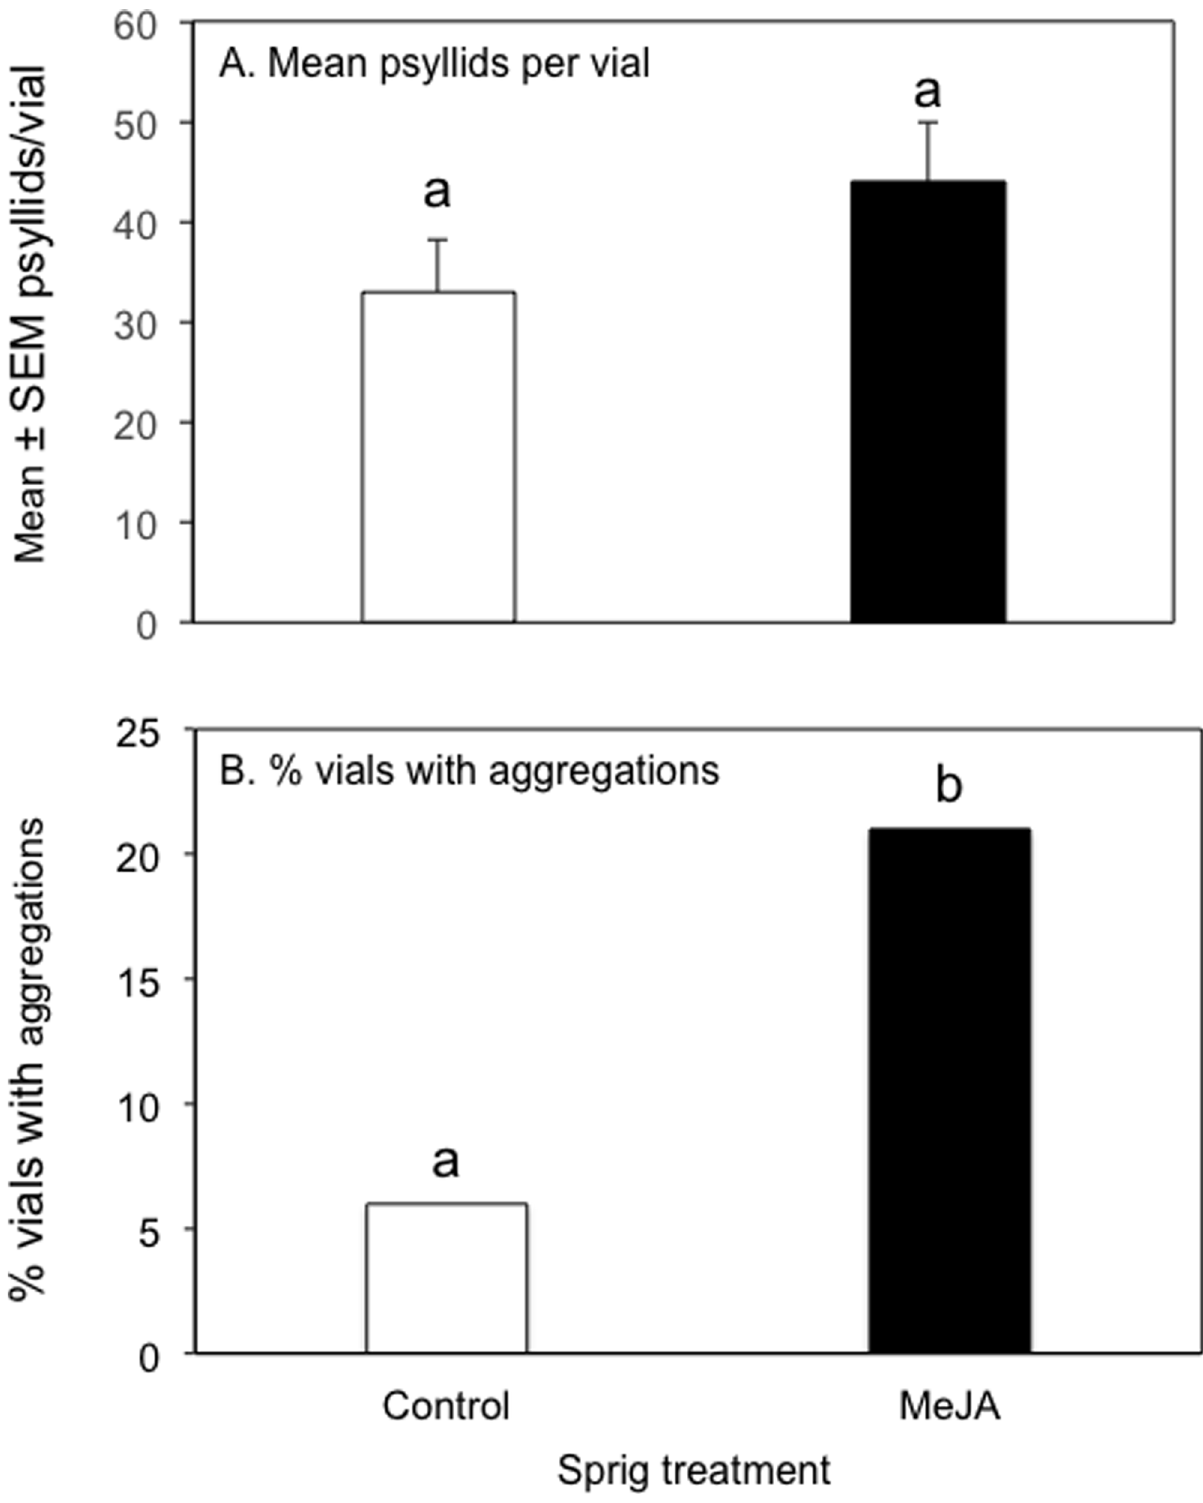
Fig 5. Results of aggregation behavior assay. (A) Mean (± SEM) of psyllids per vial (t = .8928, NS, control n = 8, MJ-treated n = 11); (B) % vials with aggregations ( (cid:21) 9 psyllids/vial) (G = 9.48, P < 0.01).